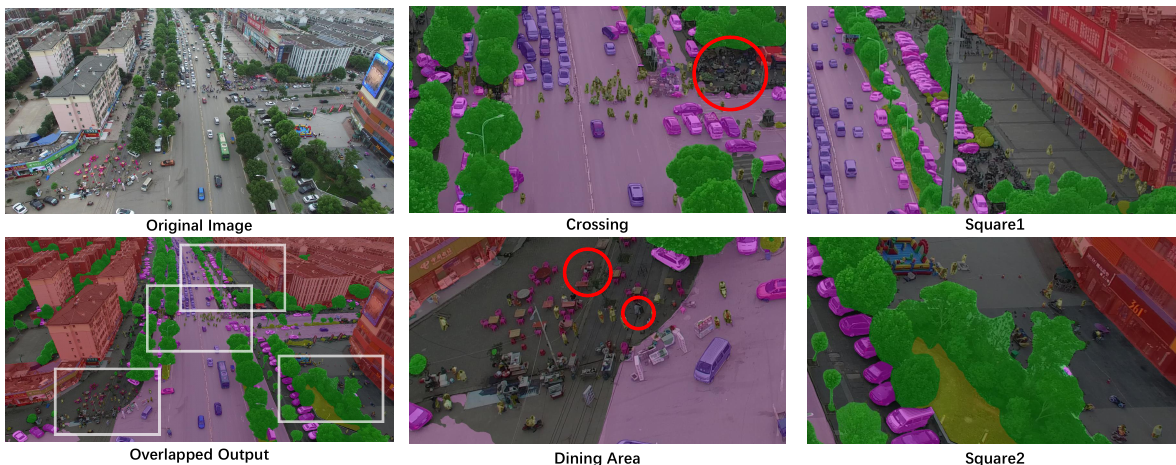
Figure 7. Qualitative example of human class segmentation by the BiMSANet. The example image is from the test set (seq22, 000900). The left column shows the original full image and the overlapped output. The middle and the right columns show the image patches cropped from the overlapped output (marked by white boxes), which all focus on the human class. The red circles mark some missing segmentation.